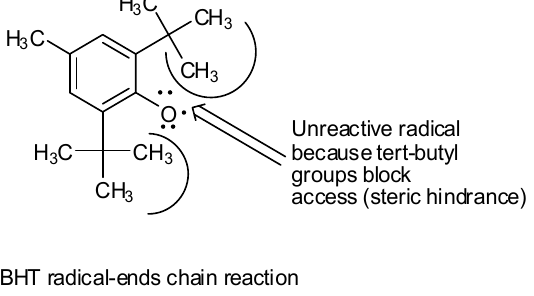
Figure 4. Steric hindrance effects on stabilization of phenoxyl radical [57].